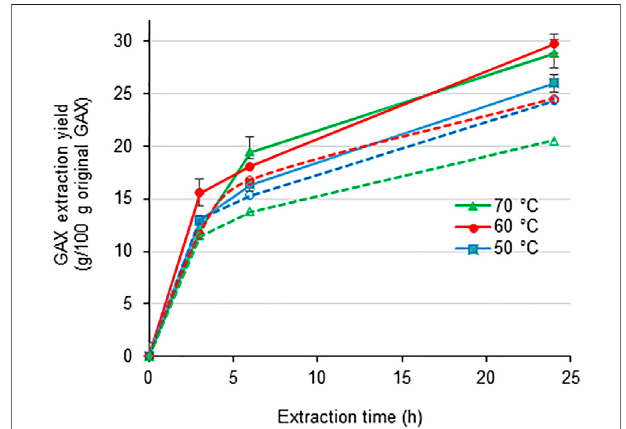
FIGURE 1 | Total yields of glucuronoarabinoxylan (GAX) extracted from alkaline-sul fi te – pretreated sugarcane bagasse mediated by commercial xylanase (luminase at 5 U/g substrate) acting at different reaction pH values and temperatures. pH 6.0 ( fi lled symbols connected by continuous lines); pH 8 (empty symbols connected by dotted lines).